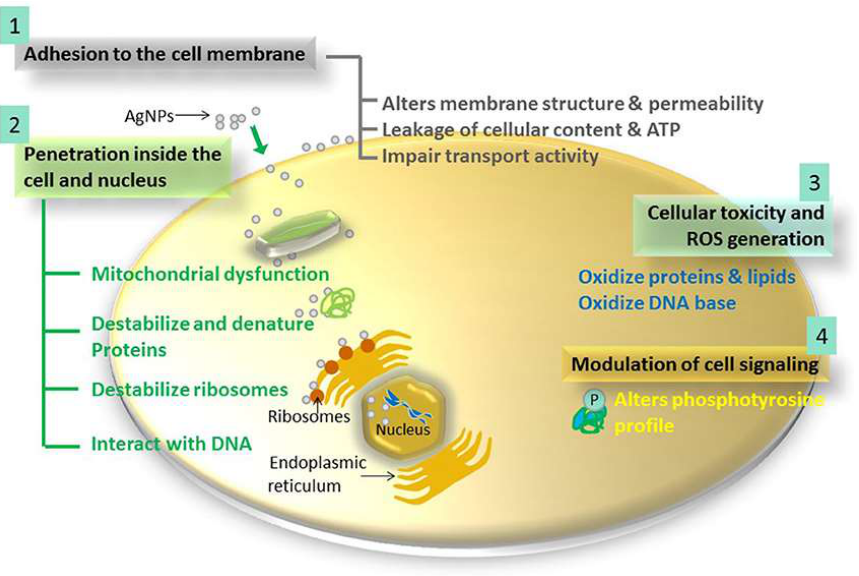
Figure 1. Schematic of the four main mechanistic actions of AgNPs against bacterial cells, resulting in cell death [16]. Reprinted with permission.